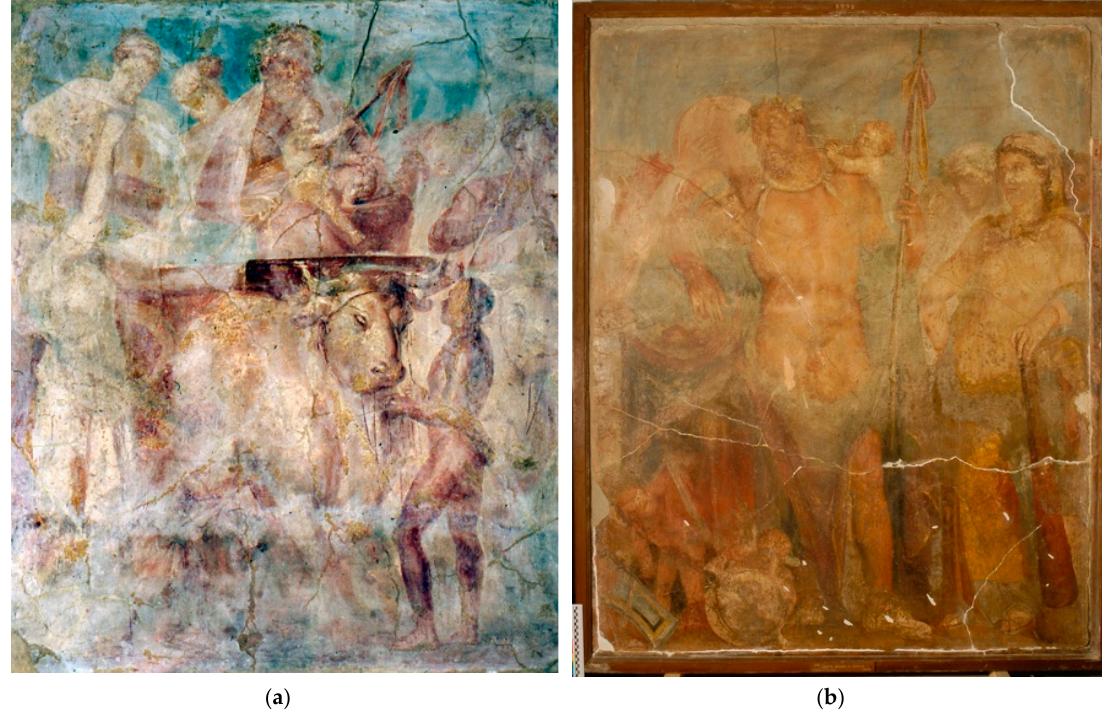
Figure 8. Wall Paintings from Room 16 (used by permission). ( a ) Procession of Bacchus. Image Courtesy: Kelly McClinton, 2017, on concession of the Ministero dei Beni e delle Attività Culturali e del Turismo, Parco Archeologico di Pompei ; ( b ) Drunken Hercules. Museo Archeologico Nazionale di Napoli , 8992. Accessed via the Expeditio Pompeiana Universitatis Helsingiensis on concession of the Ministero dei Beni e delle Attività Culturali e del Turismo, Parco Archeologico di Pompei .